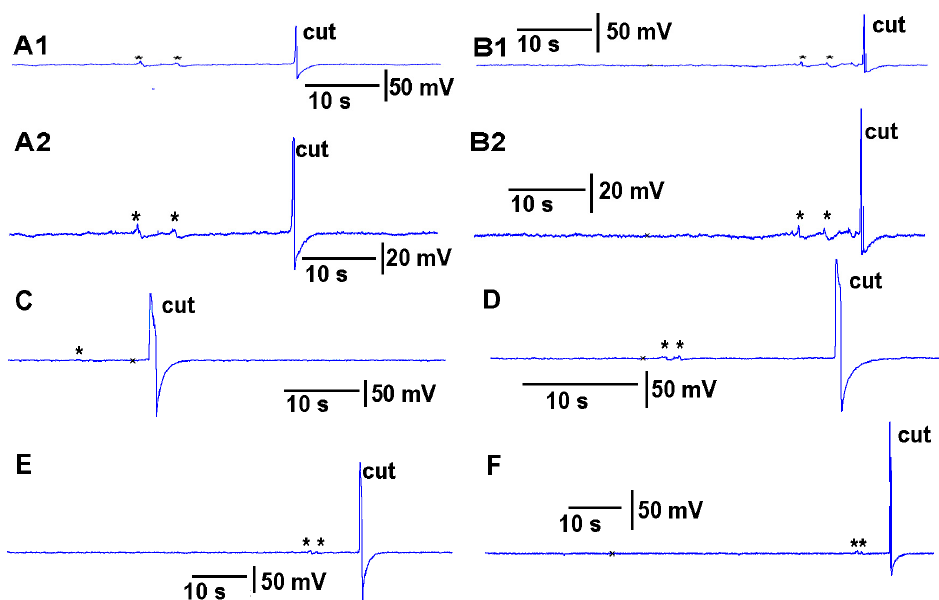
Figure 6. The effect of bending a leaf and cutting the same leaf while measuring the impedance changes by recording with both leads placed within the stem of the plant Coleus scutellarioides. The asterisk shown in each recording demarcates a bending of the leaf as a test for the effect of movement on the leaf which occurs while cutting a leaf. ( A1, B1 – F ) illustrates six different plants. ( A1 , B1 ) are presented at the same scale as ( C – F ) for comparisons, whereas ( A2 , B2 ) are enlarged to better note the changes in the responses.